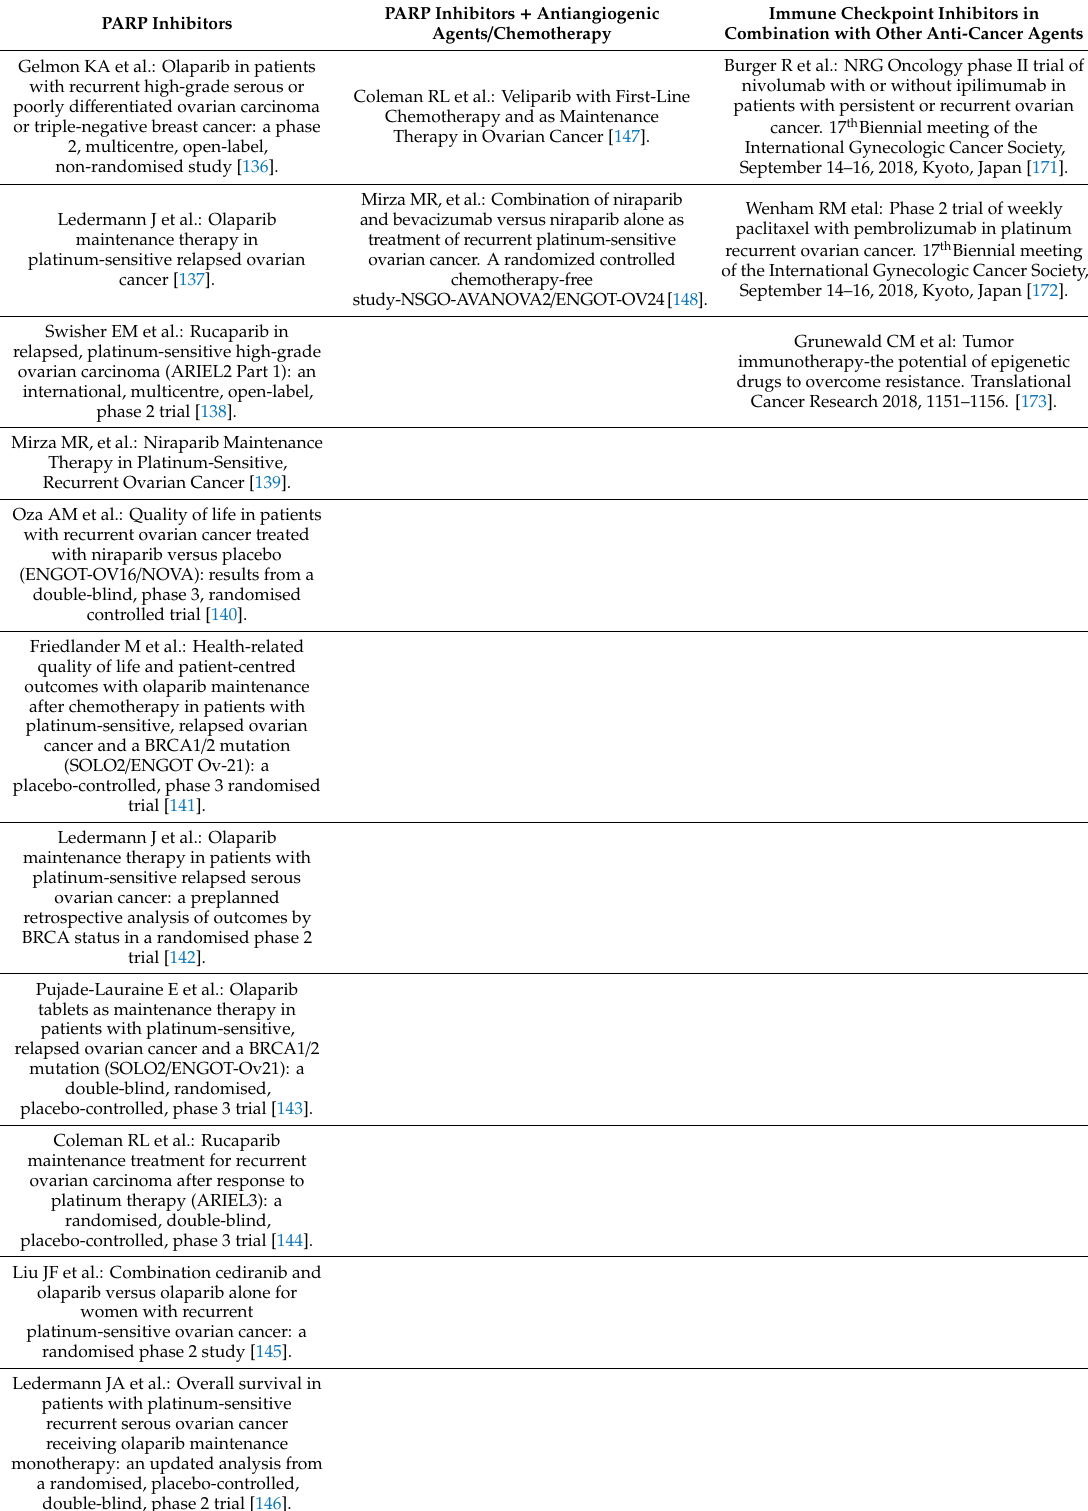
Table 1. List of clinical trials (ongoing and closed) described in the review involving PARP Inhibitors, Antiangiogenic Agents / Chemotherapy and Immune Checkpoint Inhibitors. PARP